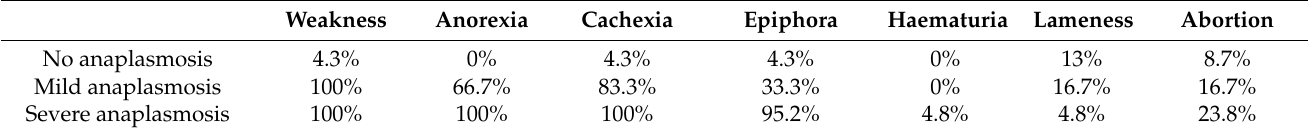
Table 2. Percentage of farms with mild or severe anaplasmosis that reported have seen the following clinical signs in the animals—weakness, anorexia, cachexia, epiphora, haematuria, lameness and abortion—in comparison with those without anaplasmosis.